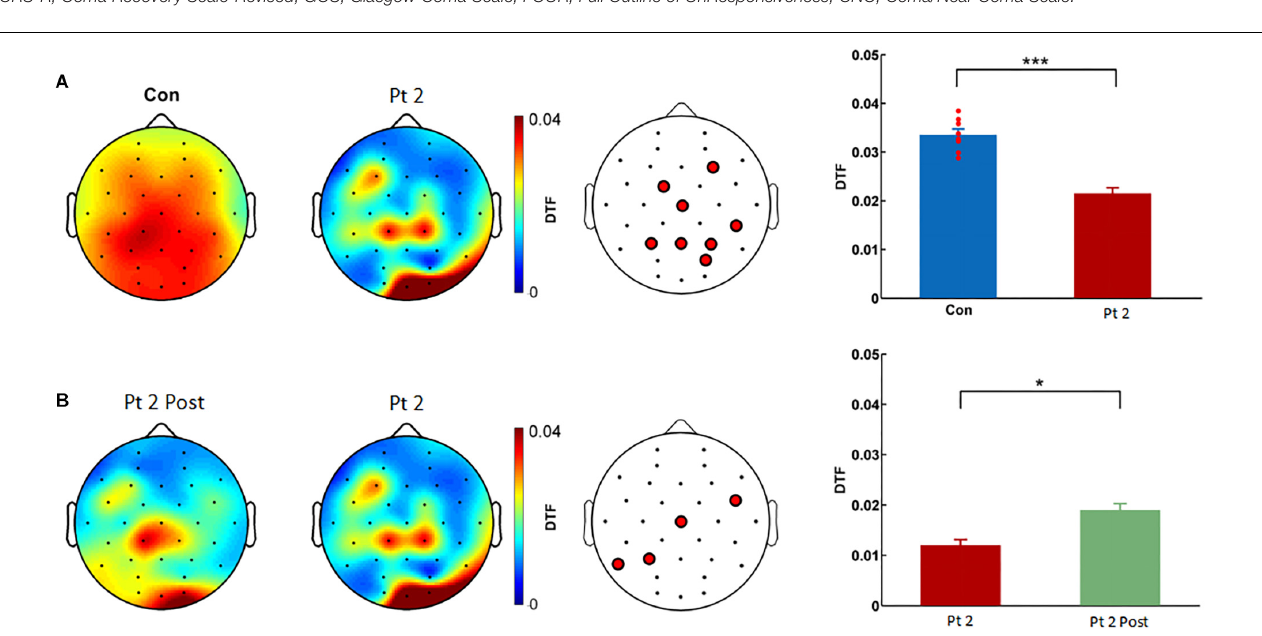
FIGURE 5 | Comparison of DTF in the gamma frequency of EEG between controls and patient 2 before and after routine treatment. (A) DTF spatial distribution in healthy controls (Con) and patient 2. First panel: eight healthy controls. Second panel: compared to the eight healthy controls, patient 2 showed a significantly decreased DTF value in the gamma frequency in bilateral posterior regions. Third panel: eight electrodes (F4, FC1, Cz, P3, Pz, P4, PO4, and CP6) with significantly reduced DTF values in patient 2 compared to those in Con were identified. Fourth panel: the average DTF value of the eight electrodes was significantly lower in the patient 2 than in the Con ( ∗∗∗ p < 0.001, t -test/Wilcoxon’s rank sum test). The blue bar denotes the DTF value of eight electrodes in eight controls. The red bar denotes the pretreatment DTF value of eight electrodes in the patient. The DTF value (averaged across channels) of each single healthy control is shown as a dot. (B) Spatial distribution of the DTF in patient 2 before and after routine treatment. First panel: after routine treatment, patient 2 showed a significant increase in the DTF value in the gamma frequency in bilateral posterior regions. Second panel: patient 2 before treatment. Third panel: four electrodes (FC6, Cz, P3, and T5) with significantly higher DTF values ( p = 0.021) after treatment compared to those before treatment were identified ( ∗ p < 0.1). The red bar denotes the pretreatment DTF value of the four electrodes in the patient. The green bar denotes the post-treatment DTF value of four electrodes in the patient. DTF, directional transfer function; EEG, electroencephalography; Con, controls; Pt 2 Post, patient 2 after